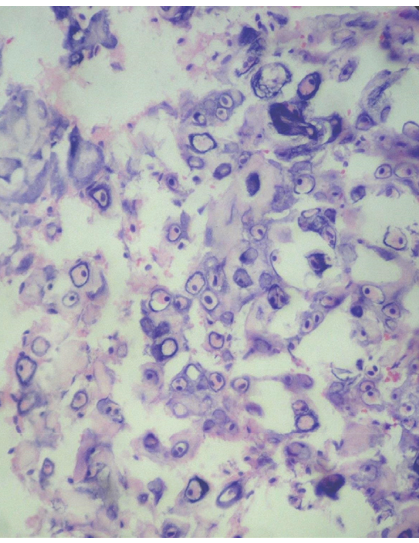
Figure 4: Photomicrograph showing no cellular atypia (H&E, 40x).